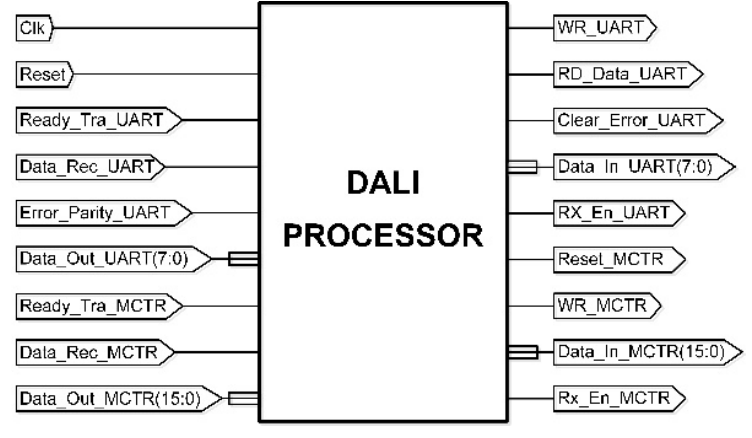
Figure 8. DALI Processor Entity.